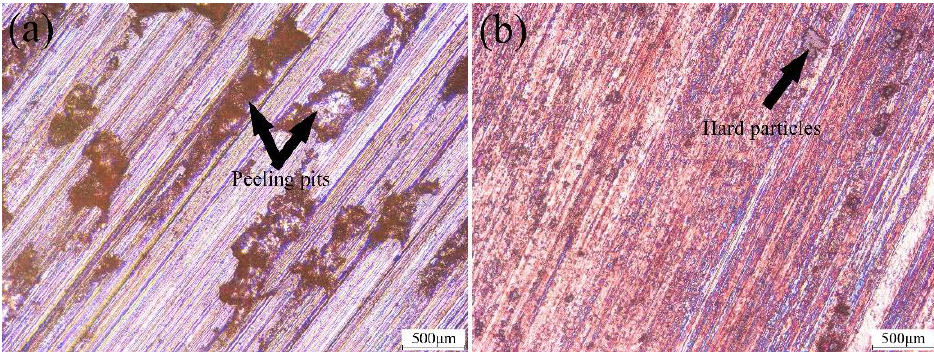
Figure 17. Worn surface morphologies of ( a ) coating 1 and ( b ) coating 2.